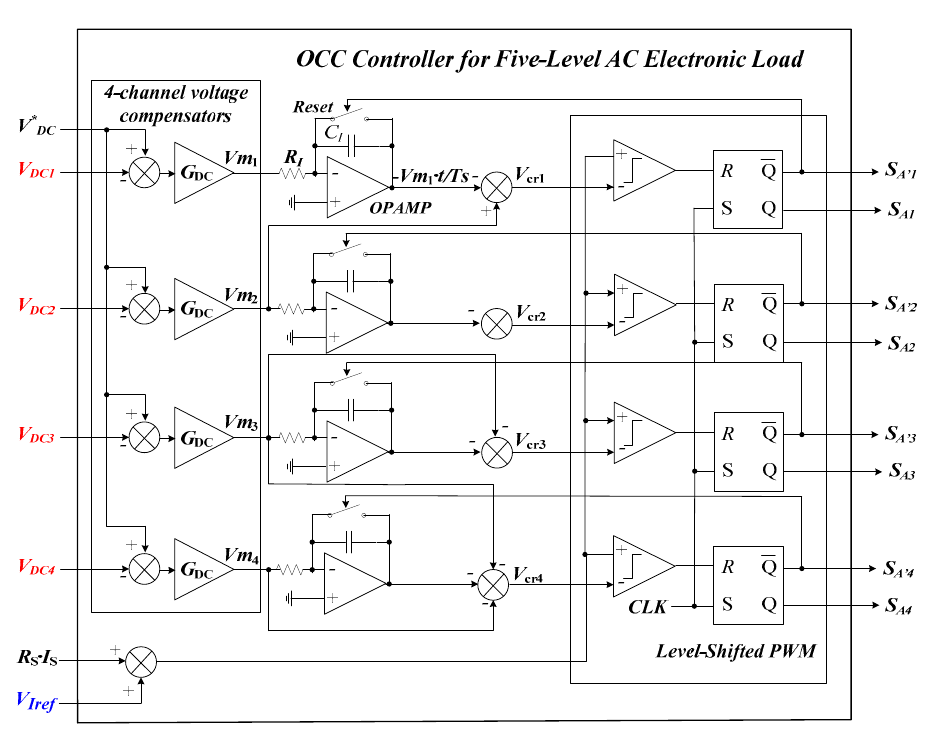
Figure 5. OCC level-shifted PWM control circuit of the five-level OCC MV